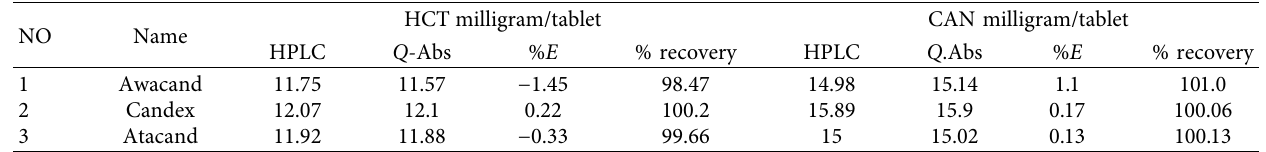
Table 17: Statistical comparison between the Q -absorption ratio method and HPLC.